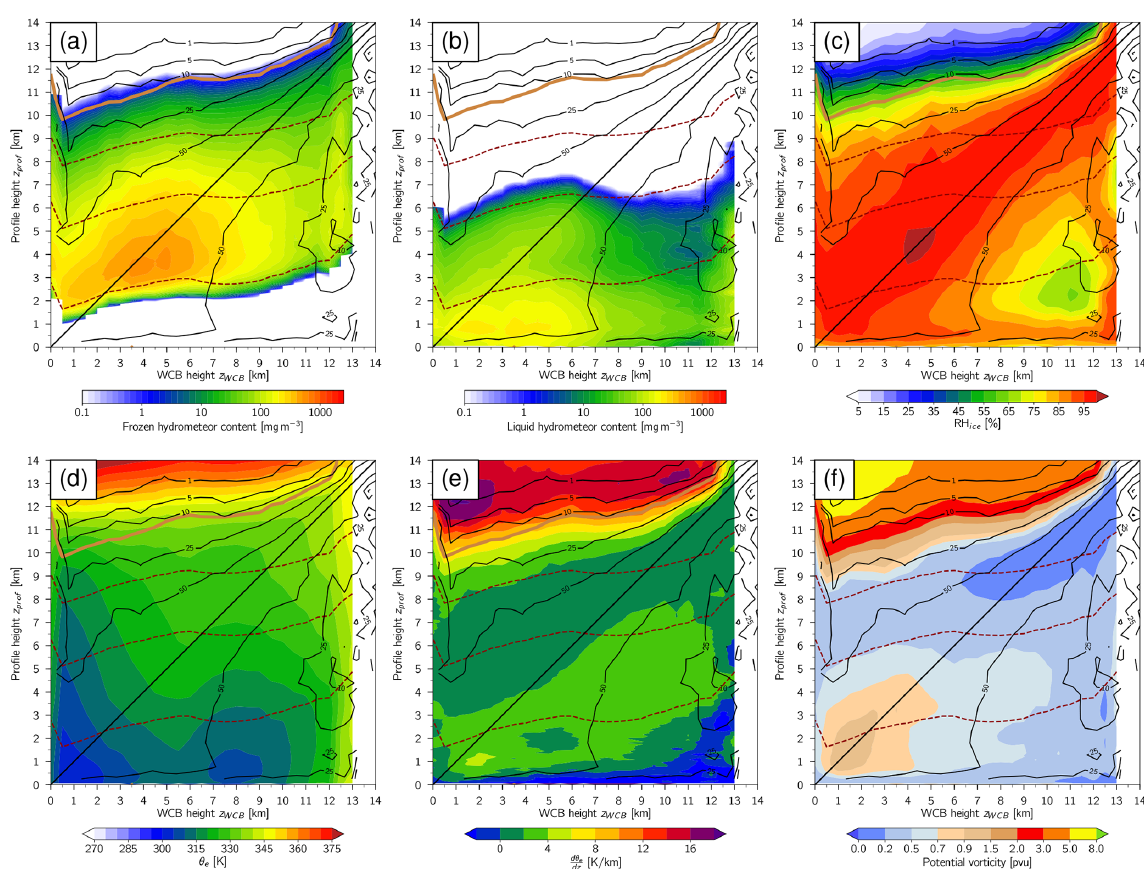
Figure 8. As Fig. 6 but for the category of strong